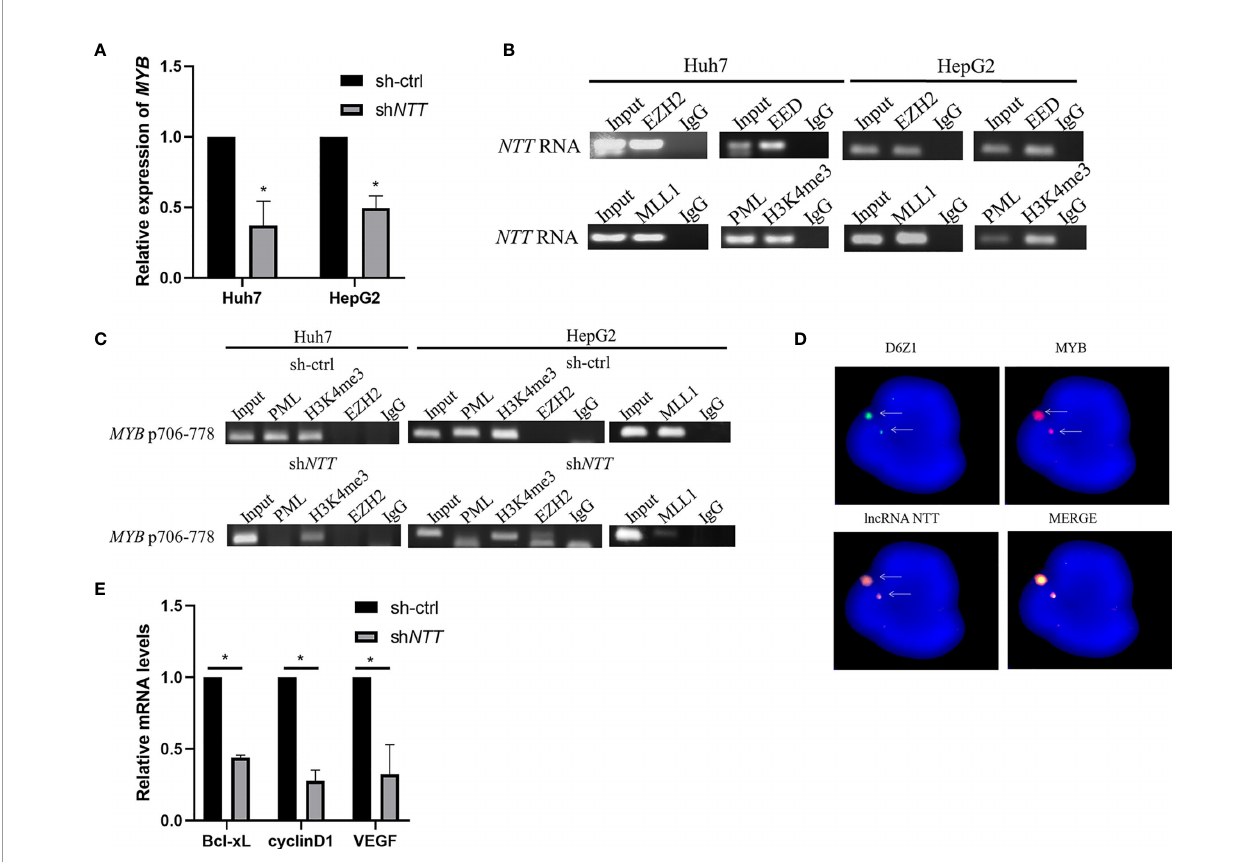
FIGURE 4 | MYB expression may be regulated by NTT through its interaction with the activated complex. (A) MYB expression was examined in Huh7 and HepG2 cells transfected with NTT shRNA. (B) RIP-RT-qPCR analysis of NTT RNA binding to PRC2 (EZH2 and EED) and activated complex (MLL1, PML, and H3K4me3). (C) DNA ChIP-qPCR analysis of PML and H3K4me3 occupancy of the MYB promoter region. (D) RNA-DNA FISH conforming that NTT interacts with MYB . (E) RT- qPCR was used to measure expression of the selected genes in NTT knockdown cells. * p <